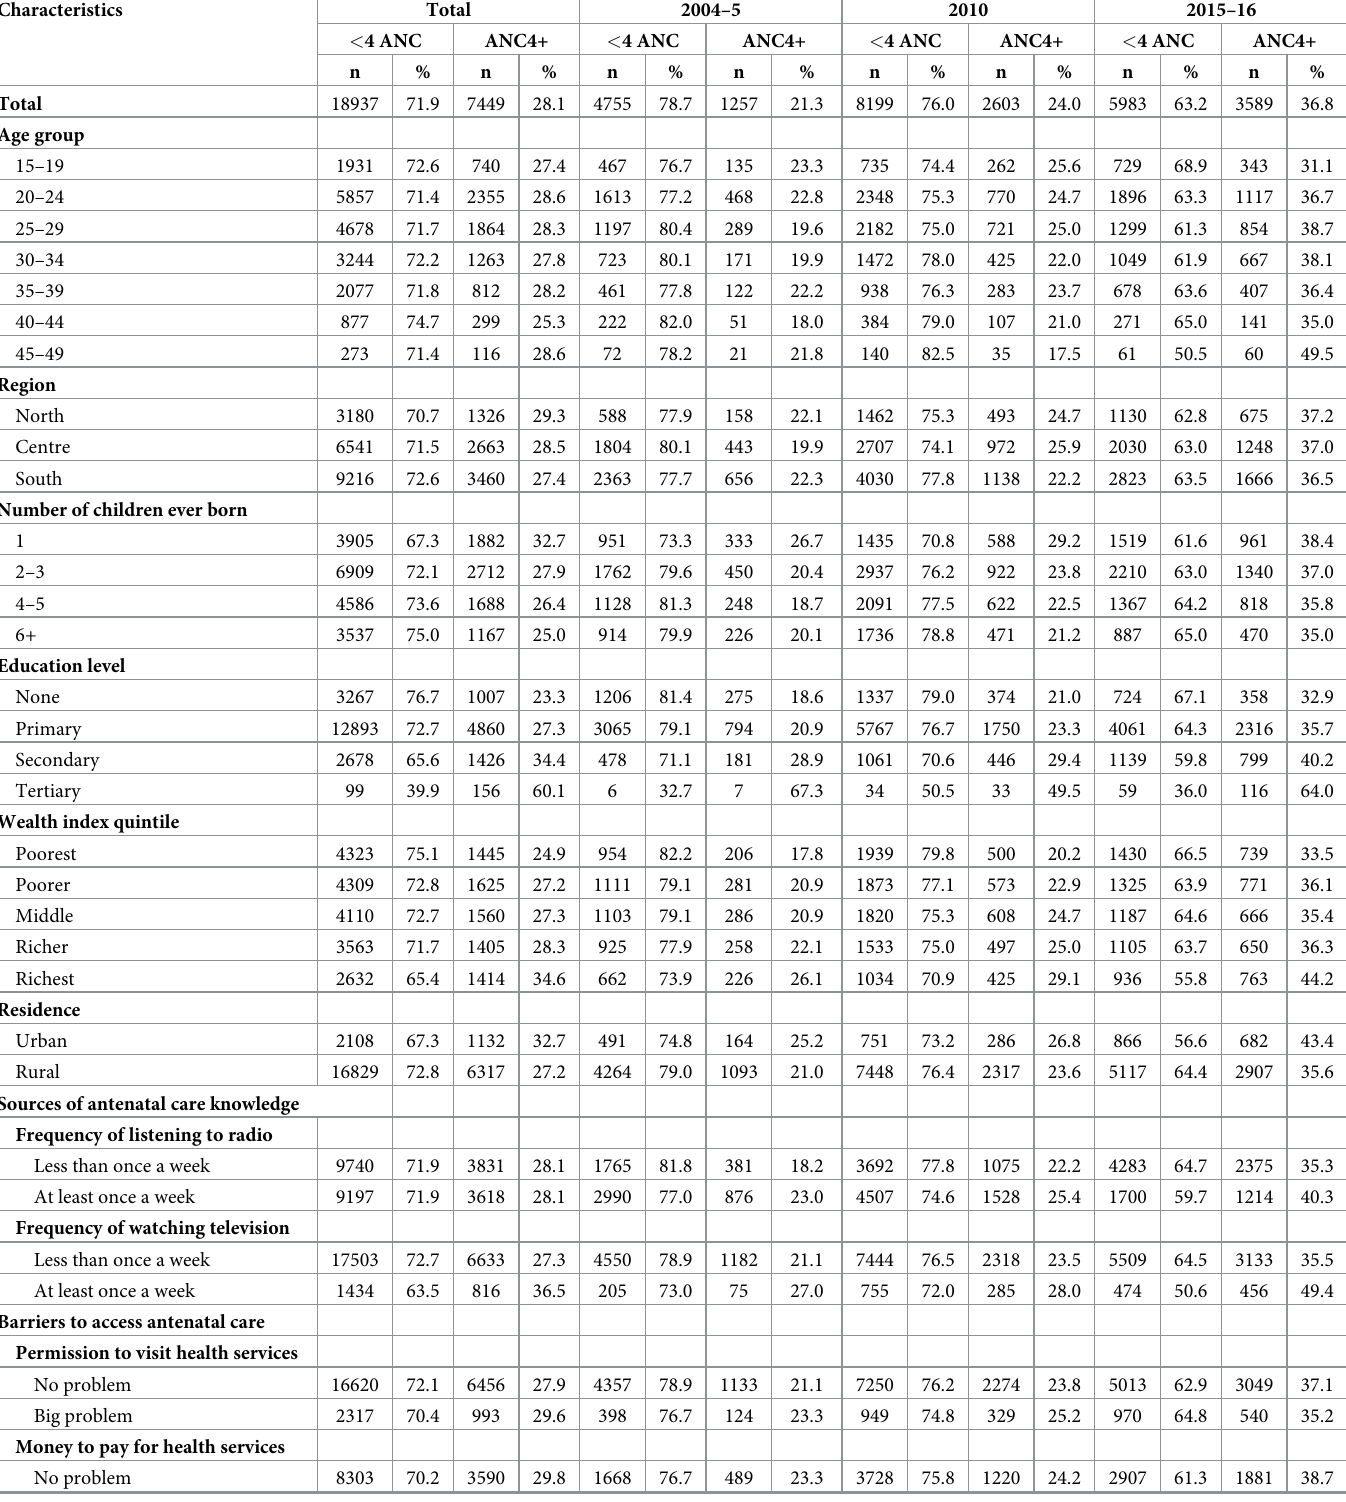
Table 2. Distribution of women by number of antenatal care visits in Malawi between 2004 and 2016.